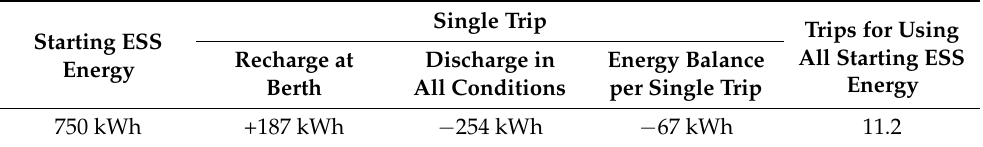
Table 8. Energy balance for case (d).